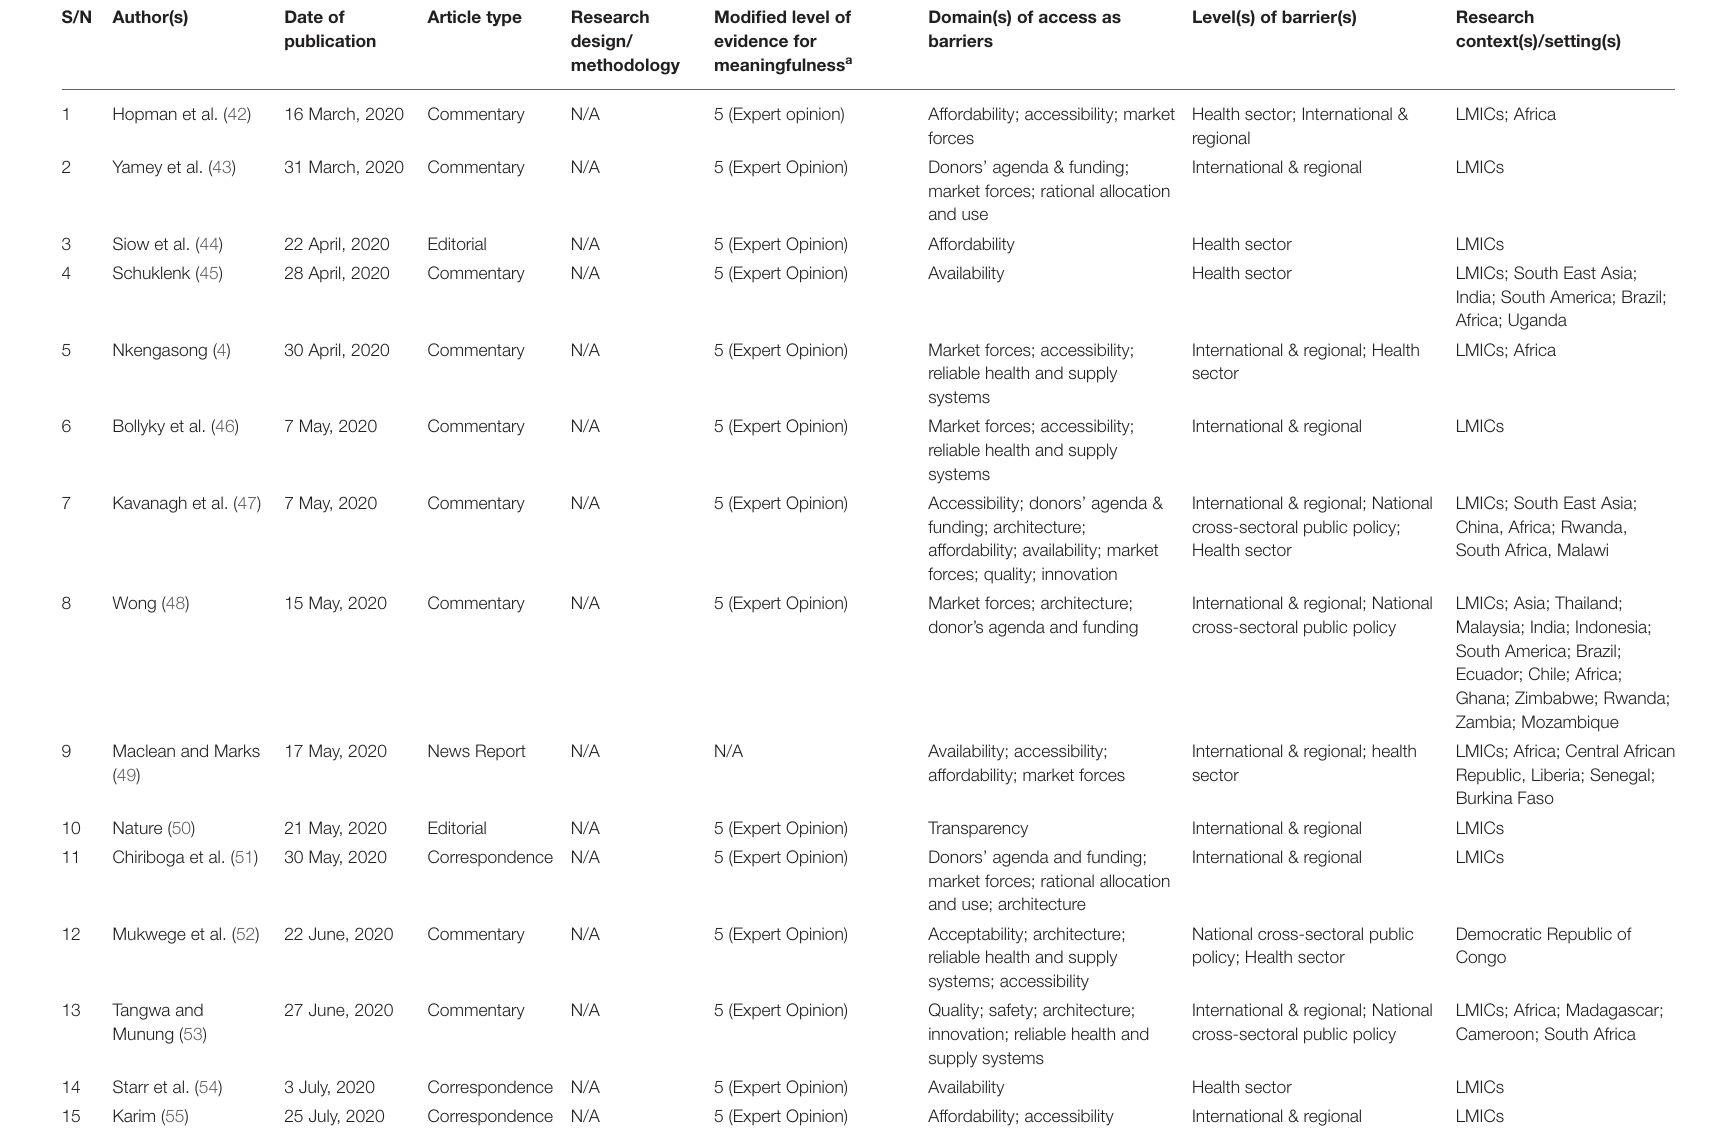
TABLE 2 | Data extraction and review